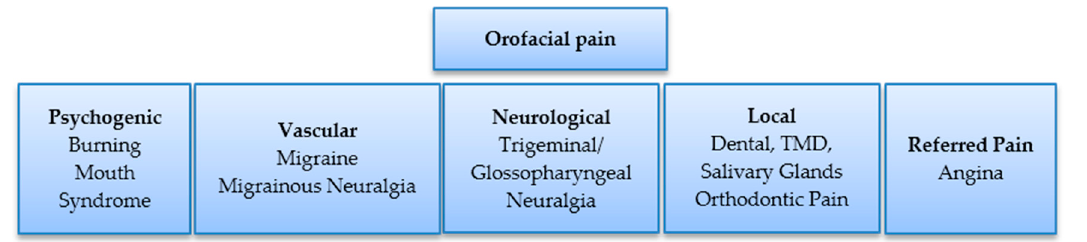
Figure 3. Common causes of pain in the oral, dental and facial tissues [40].